Question: Write a single sentence explaining what this figure depicts.
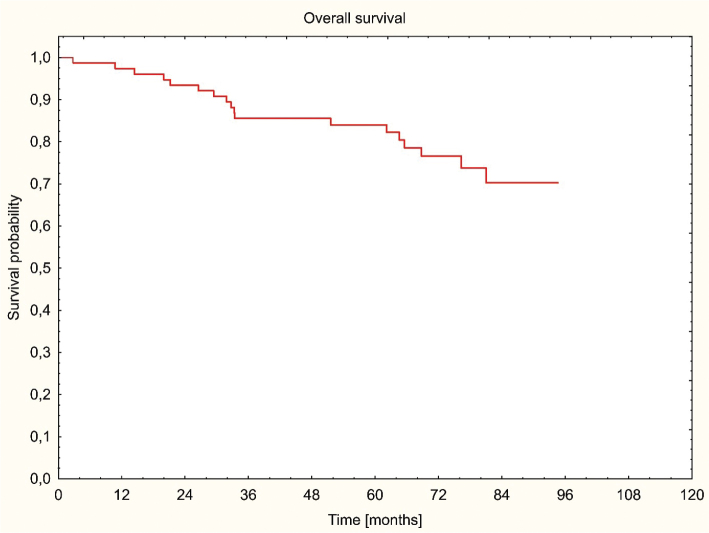
Answer: Kaplan–Meier curves for Overall Survival (OS) in chondrosarcomas and chordomas.